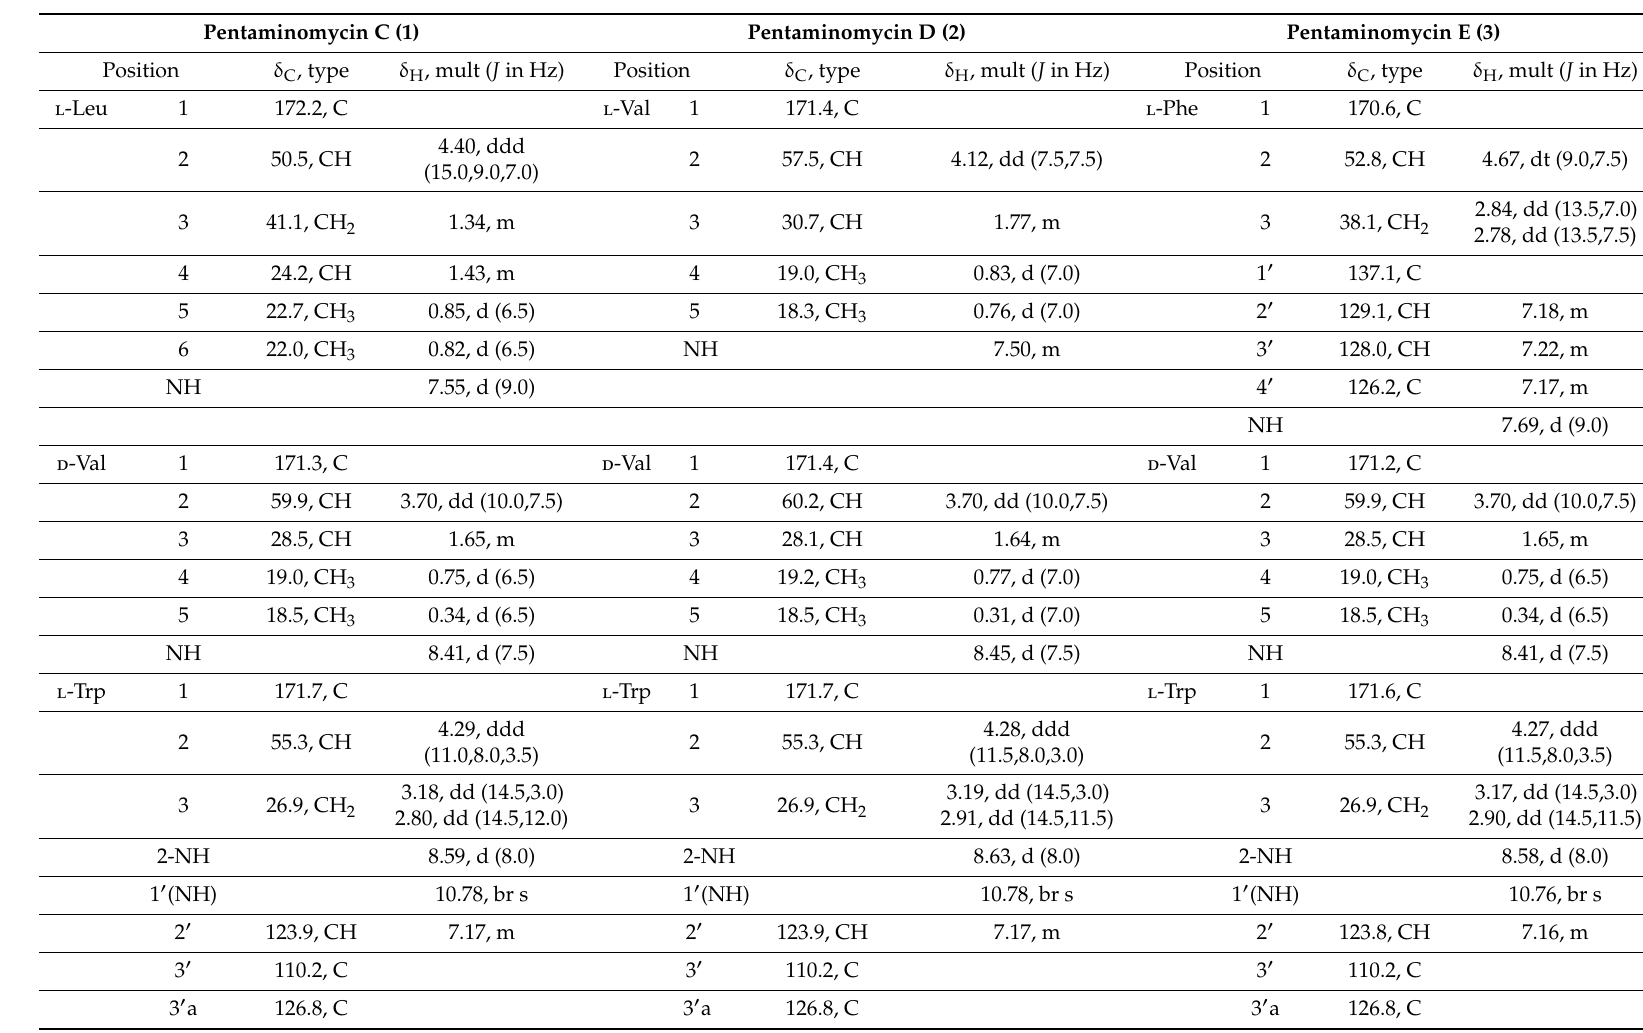
Table 1. NMR data for 1 – 3 in DMSO- d 6